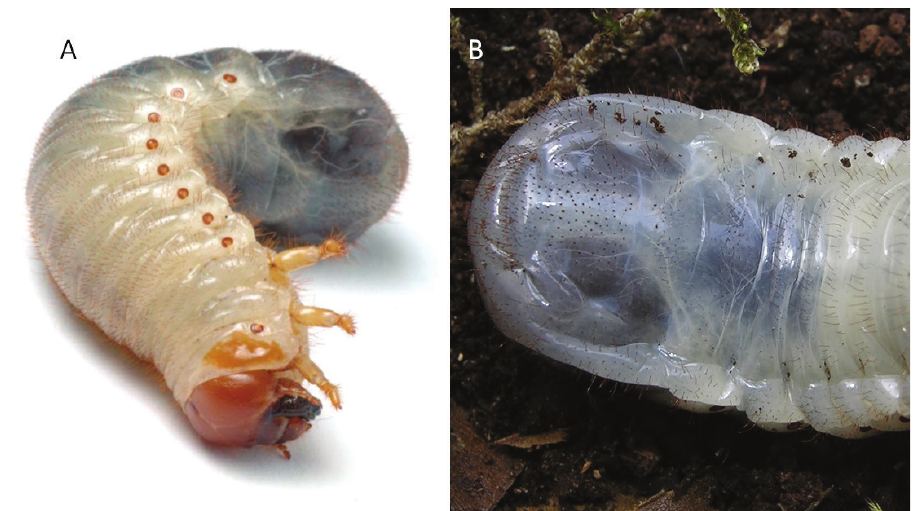
Figure 5. Larva of Osmoderma eremita . A Habitus and B Raster (ventral spiny area of the last abdominal segment). Note the lack of the palidia (the two longitudinal series of spinules occurring in the raster of most fruit chafers) and the end of the legs provided with a short and stout claw (see text for detailed expla- nation). ( A photo by Sonia Dourlot, from Dubois 2009 B photo by Benjamin Calmont).